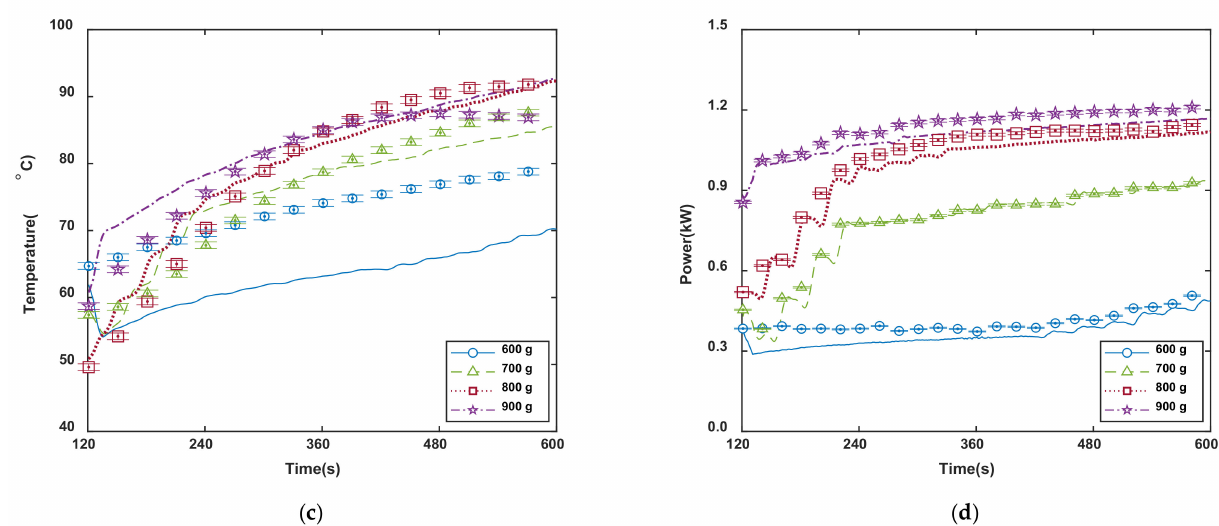
Figure 9. Prediction results of dynamic characteristic for each parameter using test data: ( a ) condensation temperature; ( b ) degree of subcooling; ( c ) compressor discharge temperature; ( d ) power